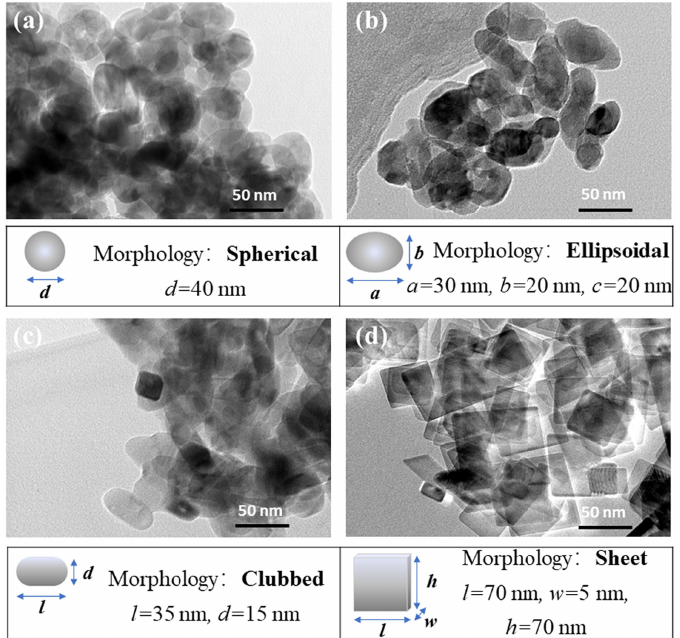
Figure 7. TEM images and morphology descriptions for TiO 2 nanoparticles with different shapes: ( a ) spherical, ( b ) ellipsoidal, ( c ) clubbed, and ( d ) sheet [ 58 ] . Elias et al. studied the effects of different forms of nanoparticles in nanofluids on heat exchanger performance. The results showed an increase in both system heat transfer and thermodynamic performance. Cylindrical nanoparticles showed better performance in terms of the thermal conductivity, heat transfer coefficient, and overall heat transfer coef- ficient (see Figure 8) [59]. Figure 8. Effects of different particle shapes on the thermal conductivity of a nanofluid [59].